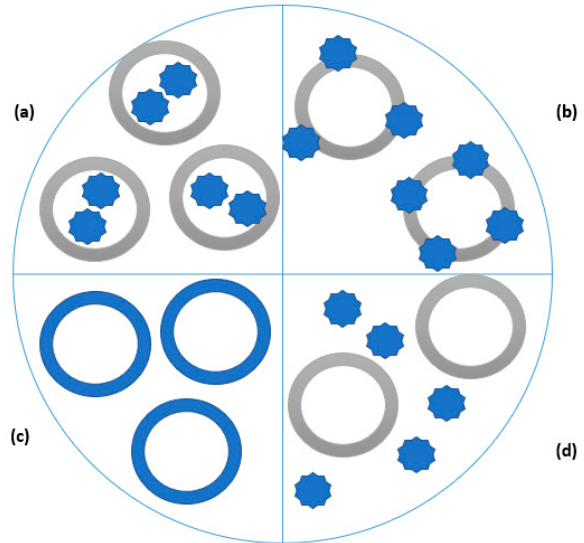
Figure 4. Schematic representation of possible combinations between nanoparticles and photosensitizers (PSs): ( a ) nanoparticles embedded with PSs; ( b ) nanoparticles with PSs bound to the surface; ( c ) nanoparticles as PSs; ( d ) PSs along nanoparticles. Created based on information from literature reference [64].